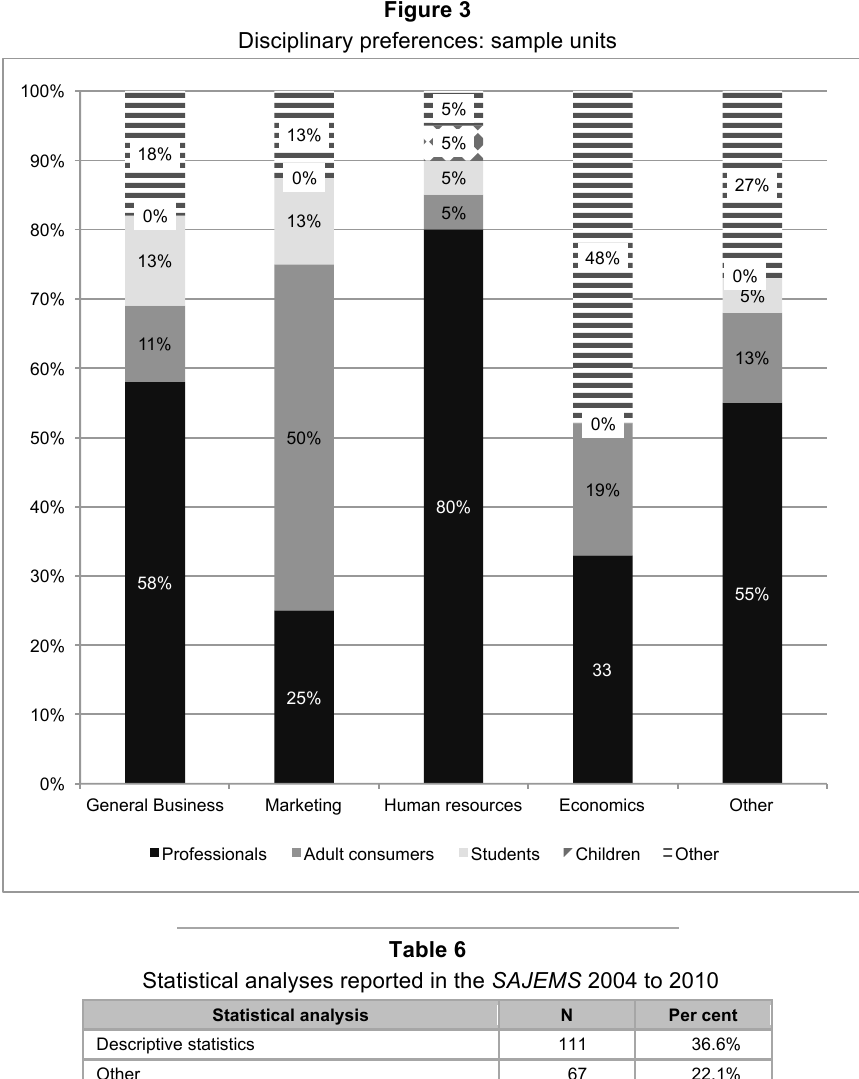
Disciplinary preferences: sample